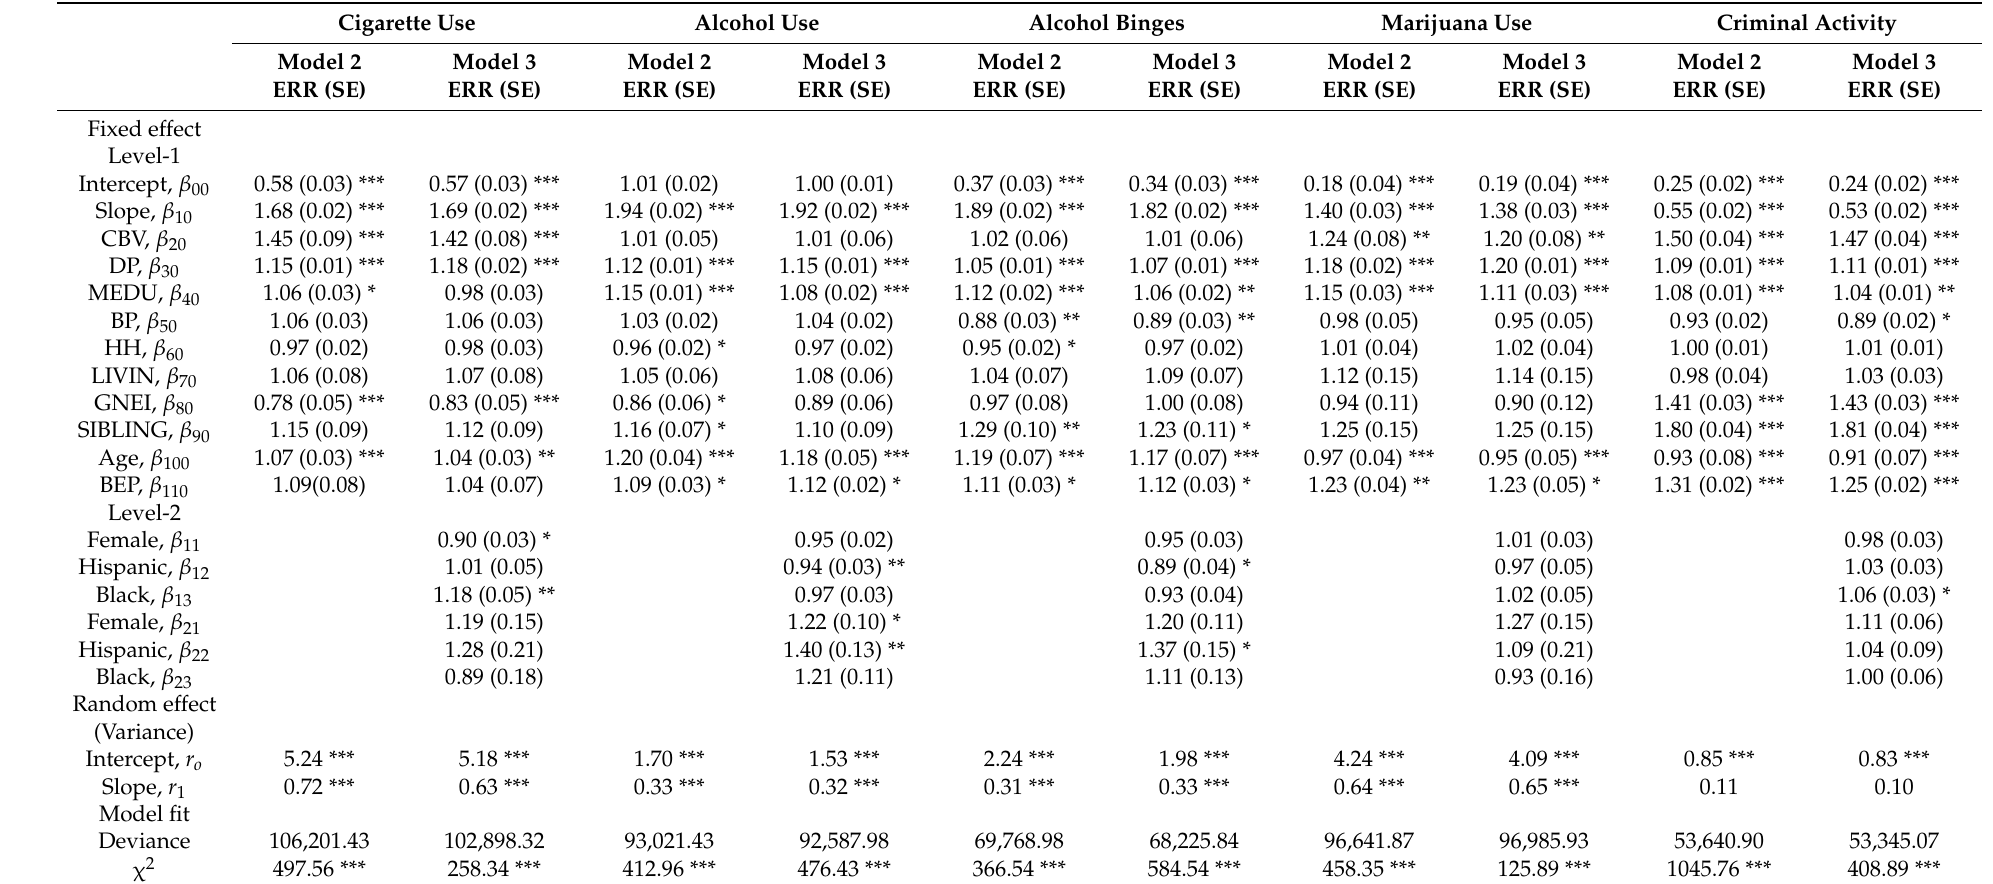
Table 4. Conditional growth models with covariates at level 1 (Model 2) and with interacting covariates at level 2 (Model